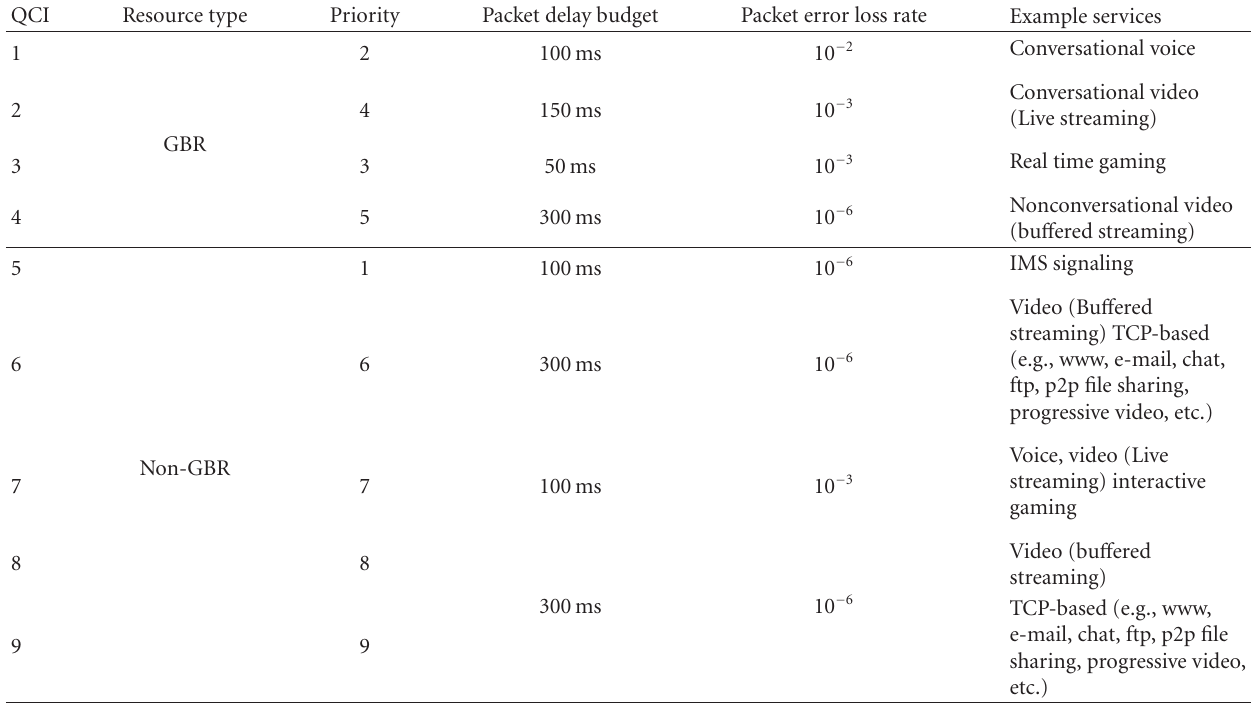
Table 5: Standardized QCI characteristics [36].